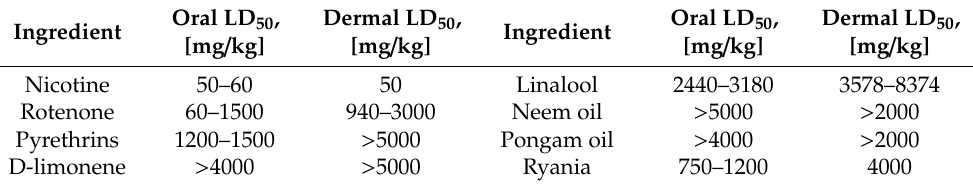
Table 1. The oral and dermal (LD 50 ) lethal dose of some ingredients / active